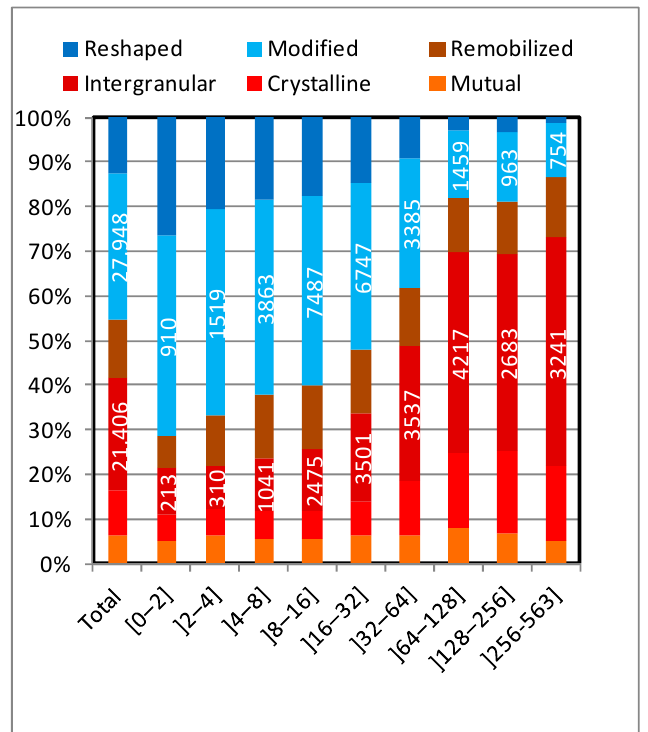
Figure 16. Proportion of the various morphofacies (reddish tints: pristine, blue: modified and reshaped) according to grain abundance in the samples. A steady increase in pristine grain abundance is noted, from 29.5% in samples with 2 or fewer grains, to 86.8% in highly anomalous samples. This suggests that “modified” and “reshaped” grains are dominantly contributed by the regional background, and are diluted by pristine grains derived from a local source. Numbers indicated inside the bars are the grain counts of the specific class.